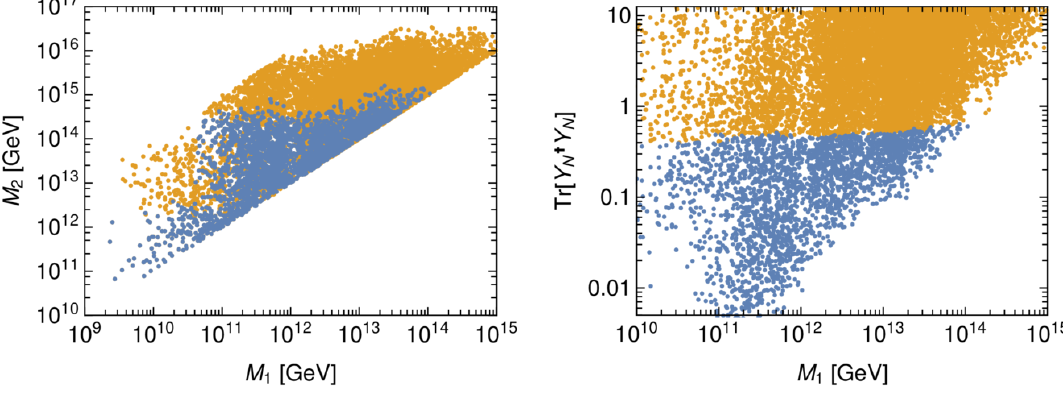
Figure 1 . Scatter plot of all the points in our scan that lead to successful leptogenesis. Points in orange correspond to the points where any of the Lagrangian coupling constants become non- perturbative below the Planck scale and/or lead to a metastable EW vacuum with a lifetime smaller than the age of the Universe. Points in blue satisfy these constraints up to the Planck scale as well as leading to successful